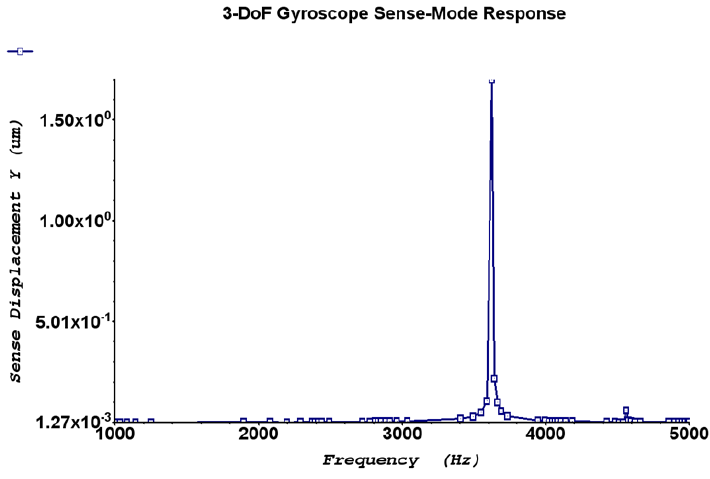
Figure 18. 1-DoF Sense mode oscillator frequency response when 1 o /s rotation rate is applied along with 0.5V AC. Resonance peak at 3.54 kHz with an amplitude of 1.70 μ m